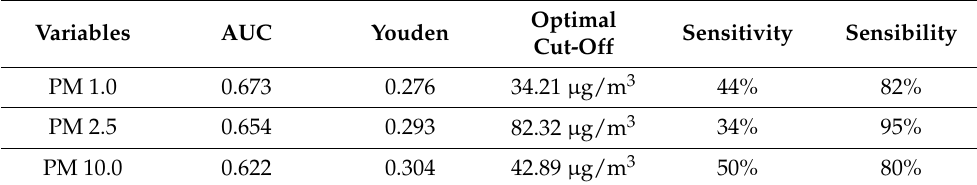
Figure 5. Receiver operating characteristic (ROC) curves of PM in predicting frequent exacerbations. The areas under the curves (AUCs) of PM 1.0, PM 2.5 and PM 10 were 0.673, 0.654, and 0.622, respectively. The optimal cutoff values obtained from Youden’s index are shown in Table 4. Table 4. Area under ROC curves, Youden index, and optimal